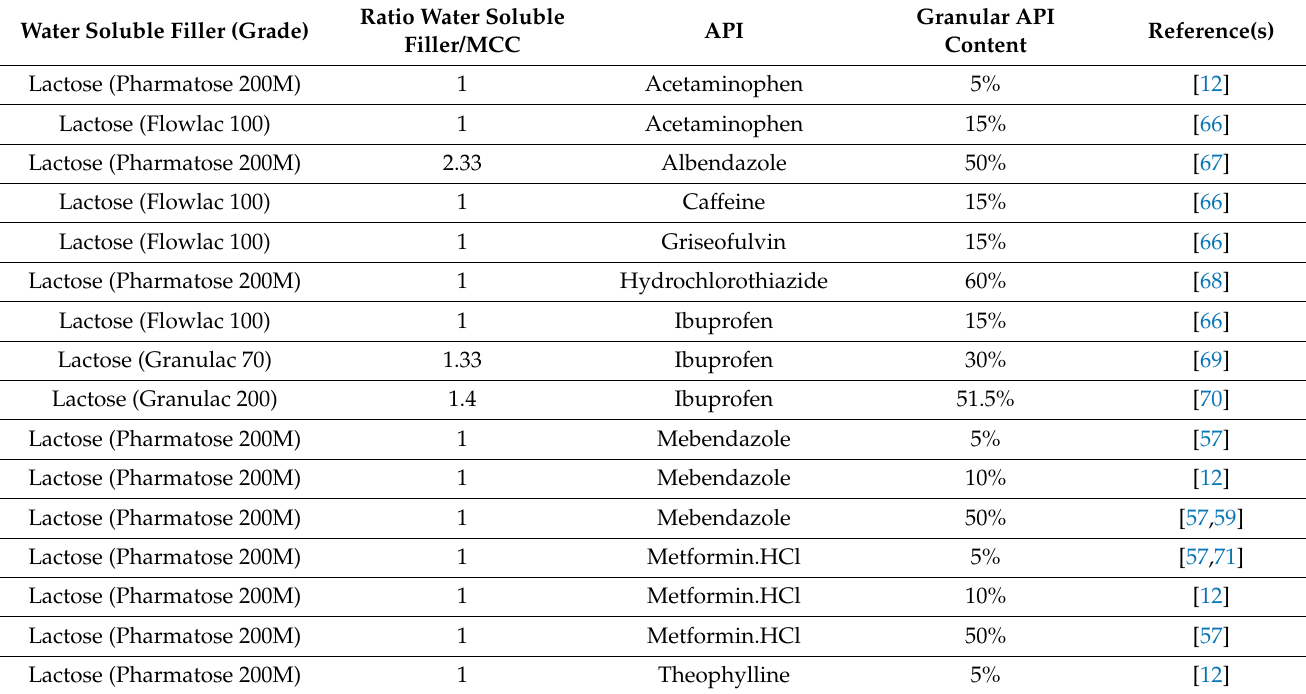
Table 1. Overview of research papers on twin screw wet granulation evaluating formulations consisting of an API and a filler combination of MCC and